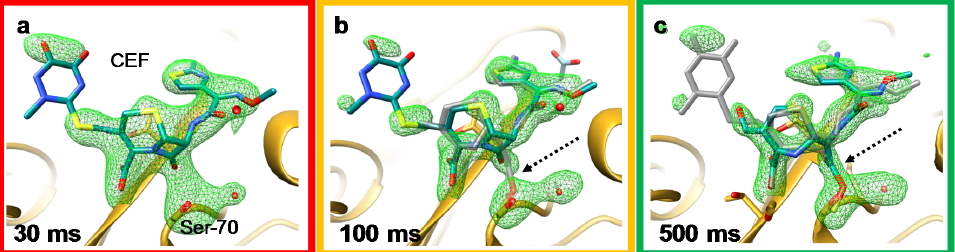
Figure 3. Ceftriaxone binding ( a ), enzyme-substrate complex formation ( b ), and the formation of the covalently bound acyl-complex ( c ) in the BlaC of M. tuberculosis determined by a mix-and-inject experiment at the LCLS. The dashed arrown in ( b ) and ( c ) indicates the formation of the covalent bond between the enzyme and substrate that happens between 100 and 500 ms. This figure is a modified version of the one shown in Olmos et al. [12].